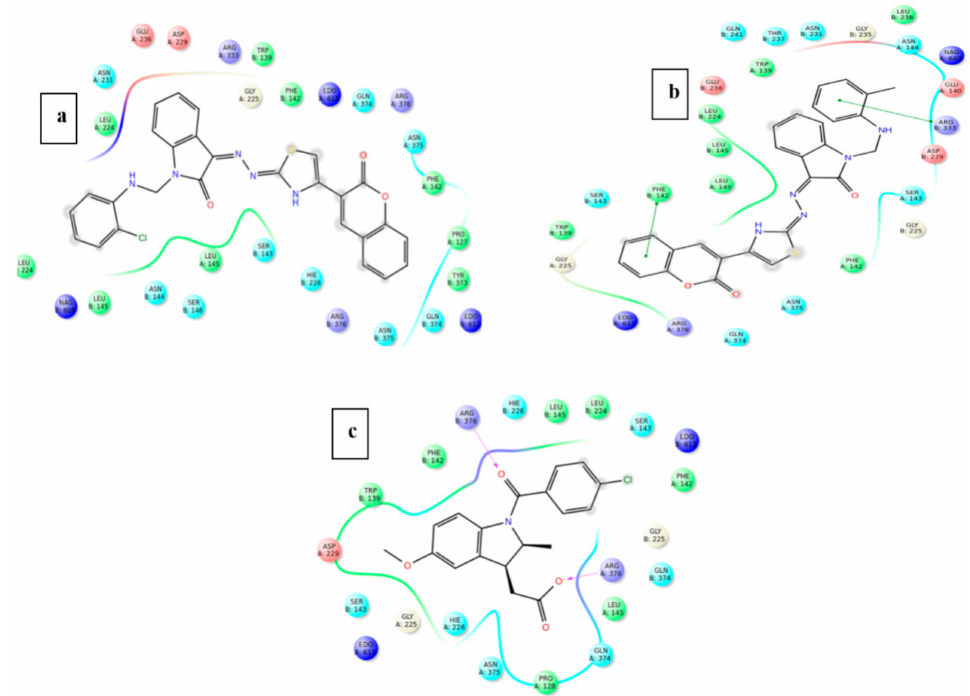
Figure 8. Ligand interaction diagram of test ligand / control drug ( a ) 4f , ( b ) 4n , ( c ) Indomethacin, with the target protein COX-2 from the